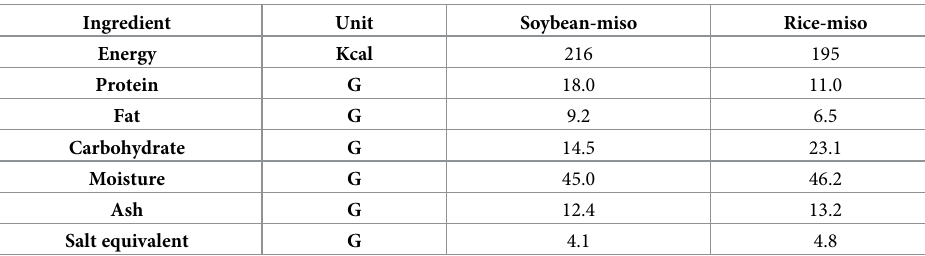
Table 1. Ingredient of miso per 100